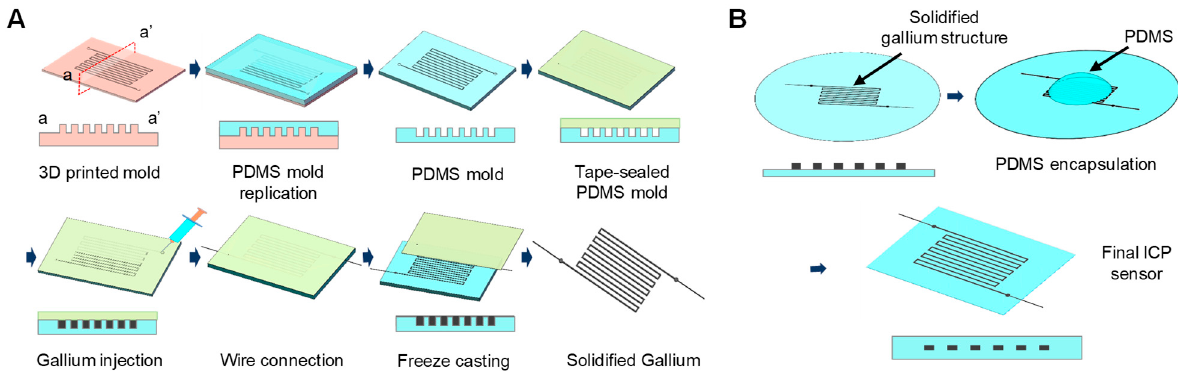
Figure 2. ( A ) Overall freeze casting fabrication process of the Ga structure. ( B ) Encapsulation of the solidified Ga structure with thin PDMS layers.